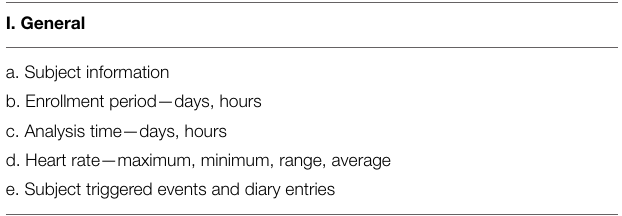
TABLE 2 | Overall organization of clinical and electrocardiographic data from ambulatory cardiac